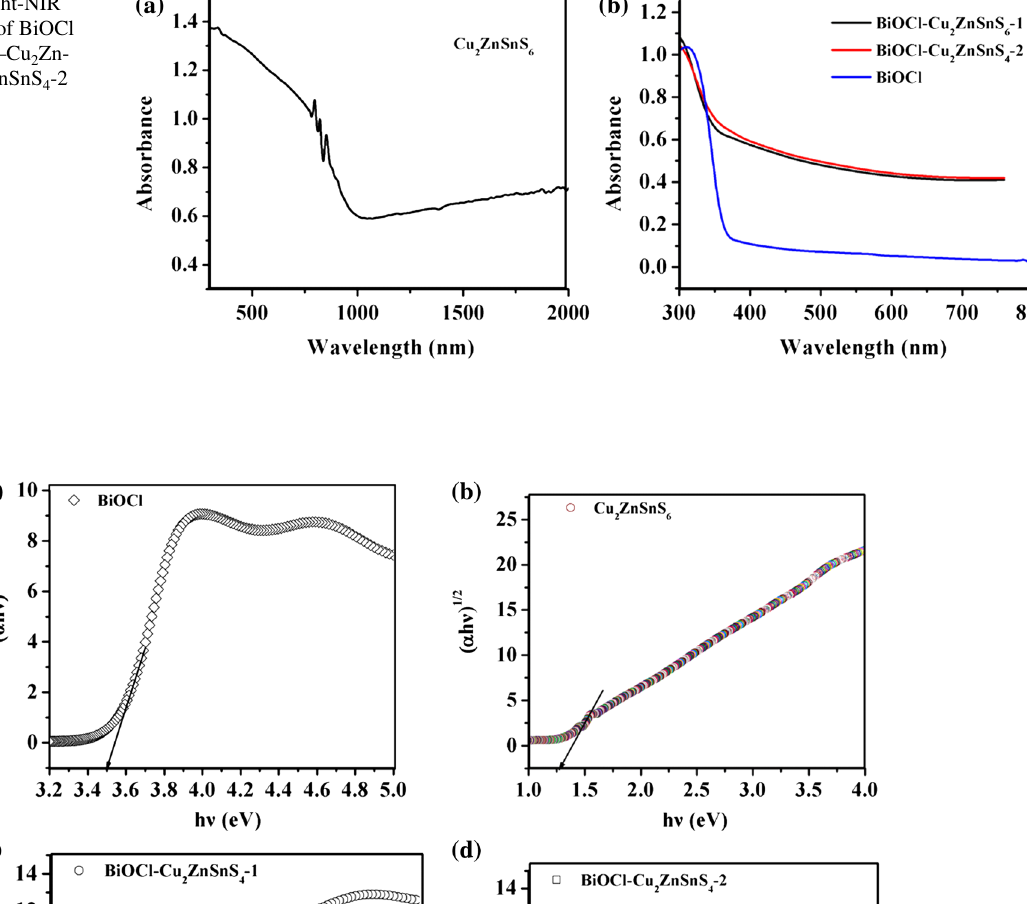
2 ZnSnS 4 QDs, c BiOCl–Cu 2 ZnSnS 4 -1 and d BiOCl–